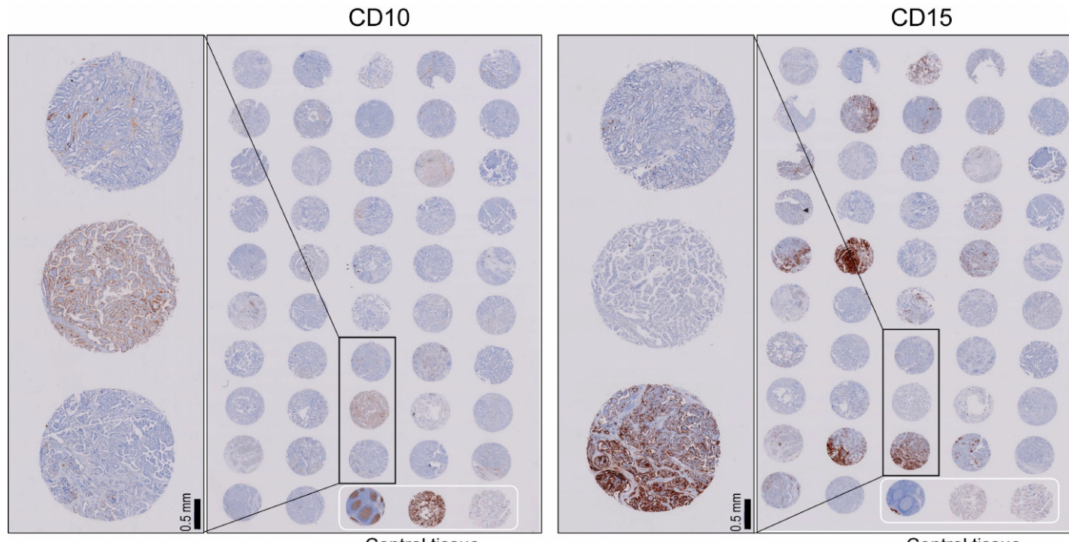
Figure 5. Immunohistochemical staining for CD10 and CD15 on tissue microarray. Tissue microarray consisted of 47 cores of tumor tissue and three cores of control tissue (normal tonsillar, placental, and thyroid